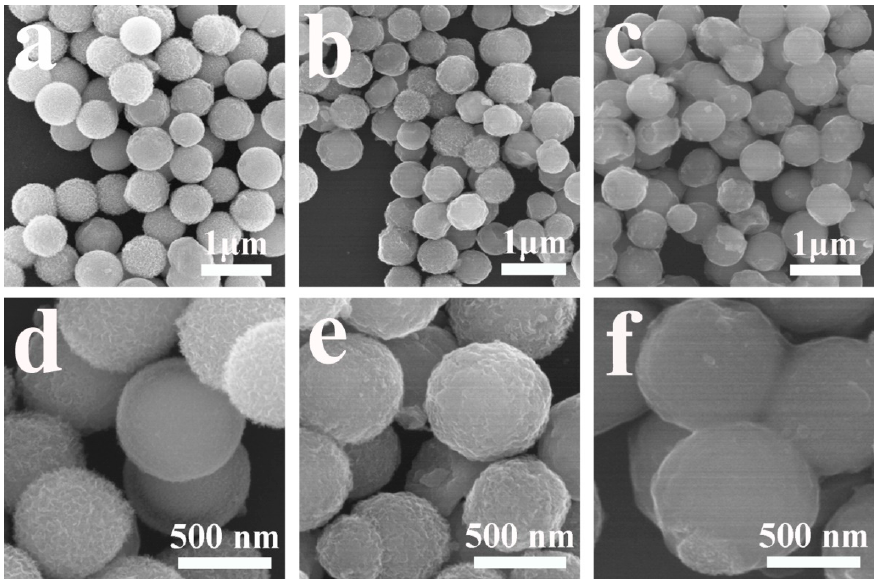
Figure 2. FESEM images of ( a , d ) NFO-YS, ( b , e ) NFO-S, and ( c , f )